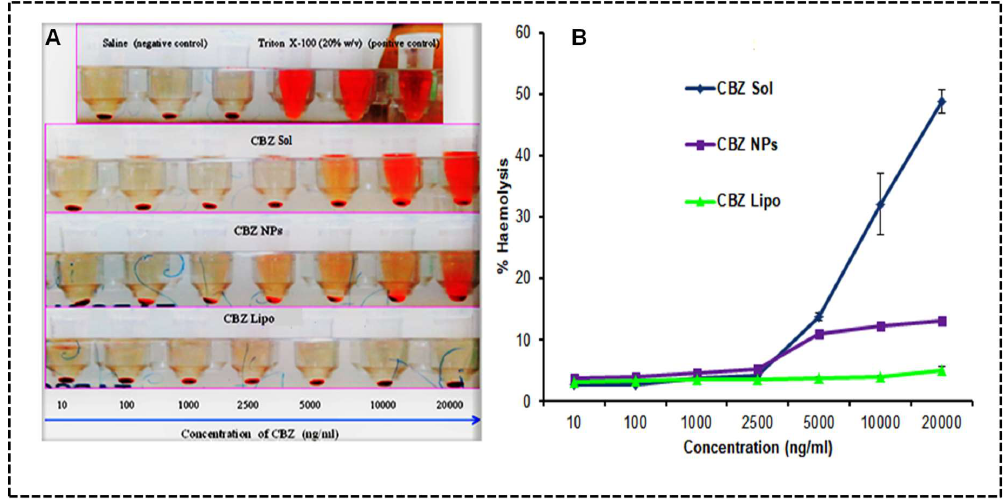
Figure 8. Ex vivo hemolysis: ( A ) Representation of red blood cells (RBCs) treated with CBZ micellar solution, CBZ NPs, and CBZ liposomes. ( B ) Percentage of hemolysis representing RBCs treated with